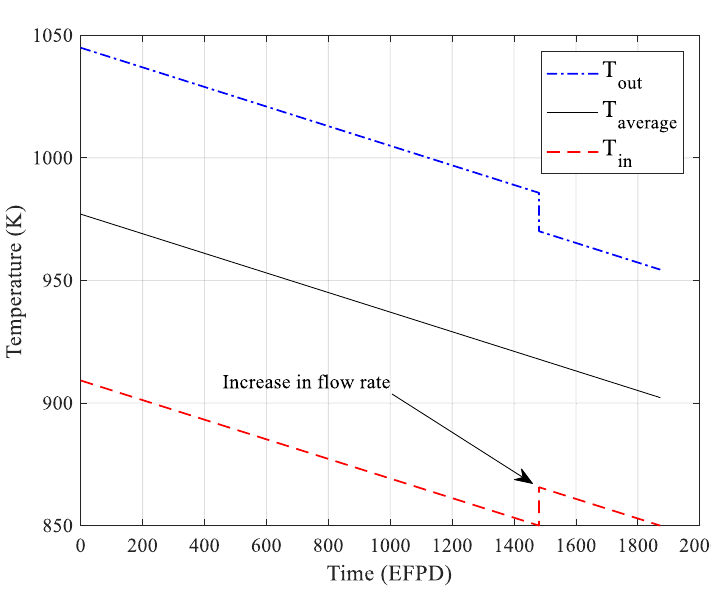
Figure 5.3. Fuel temperature variation vs EFPD at constant power of 3 GWth for the